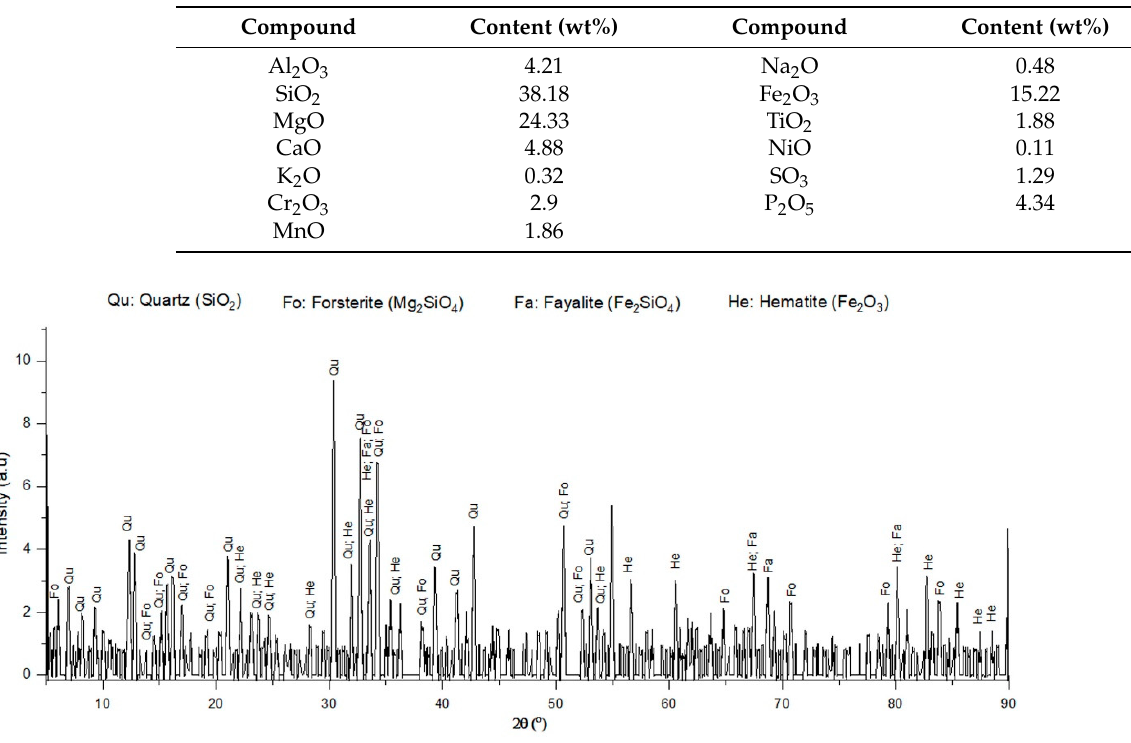
Table 6. The chemical composition of ferronickel slag by XRF.